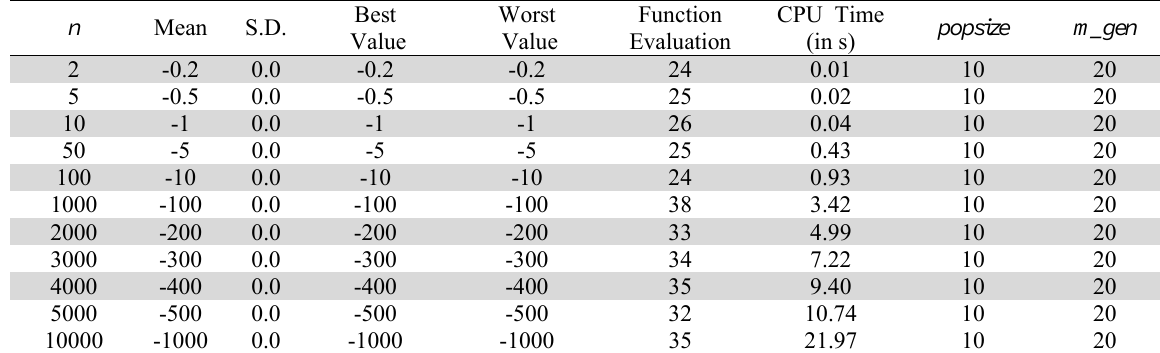
Computational Results of Problem